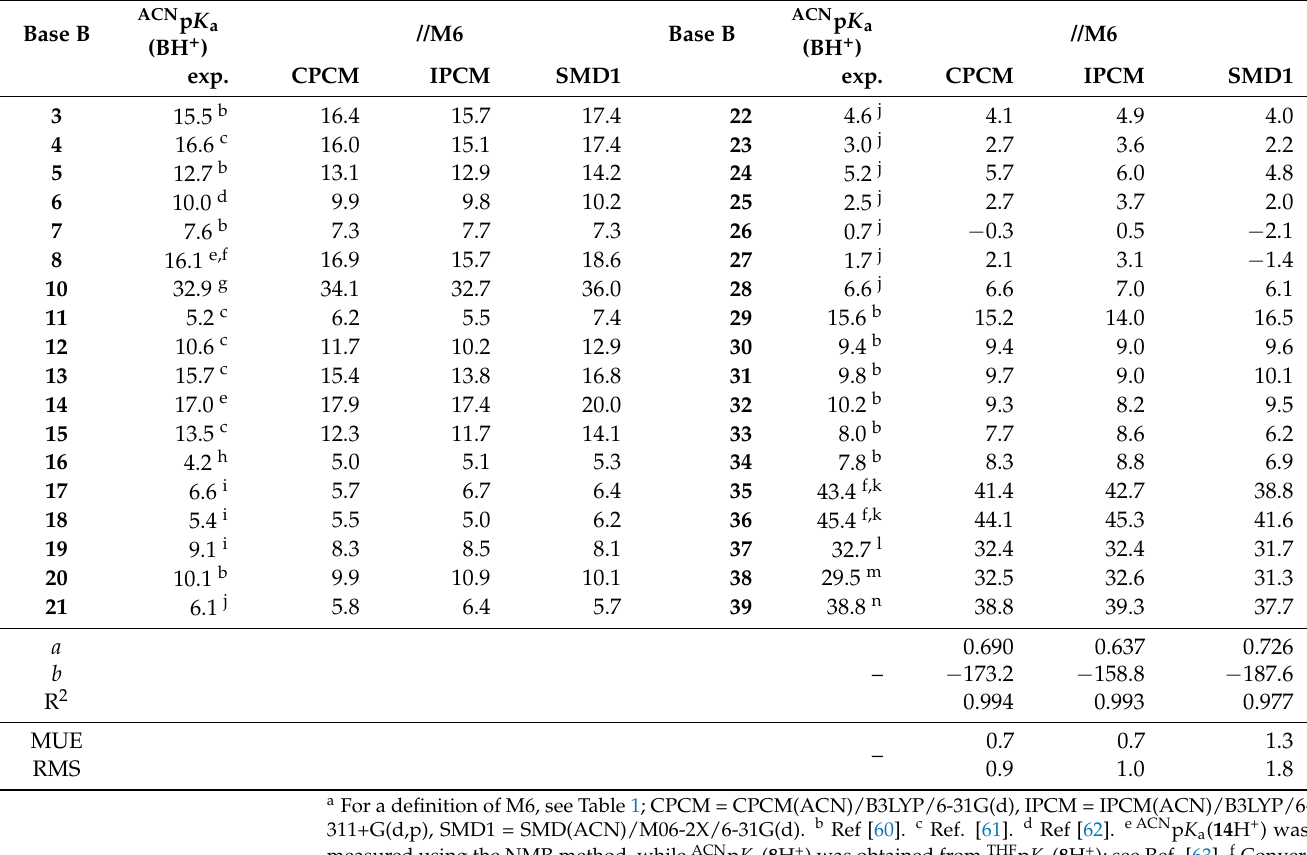
Table 2. Comparison of calculated and experimental ACN p K a s for protonated phosphines 3 – 39 a,b . Base